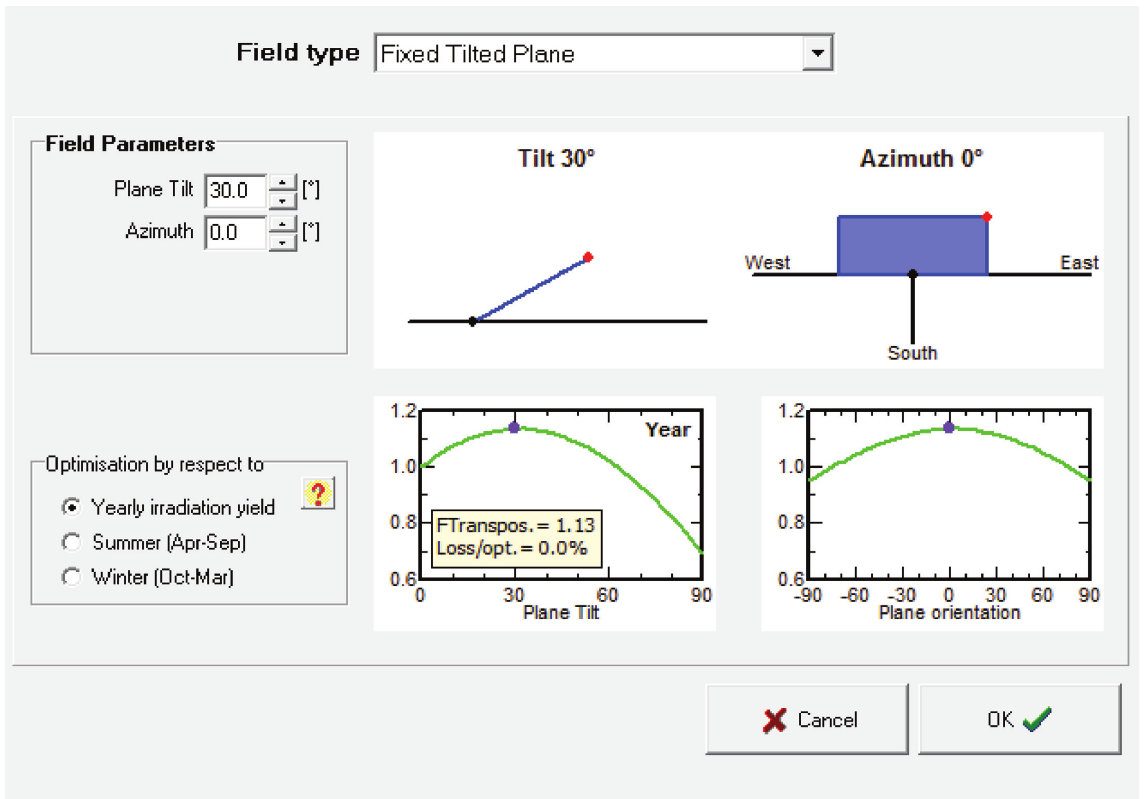
Figure 5: Sunlight angles changing throughout the day.